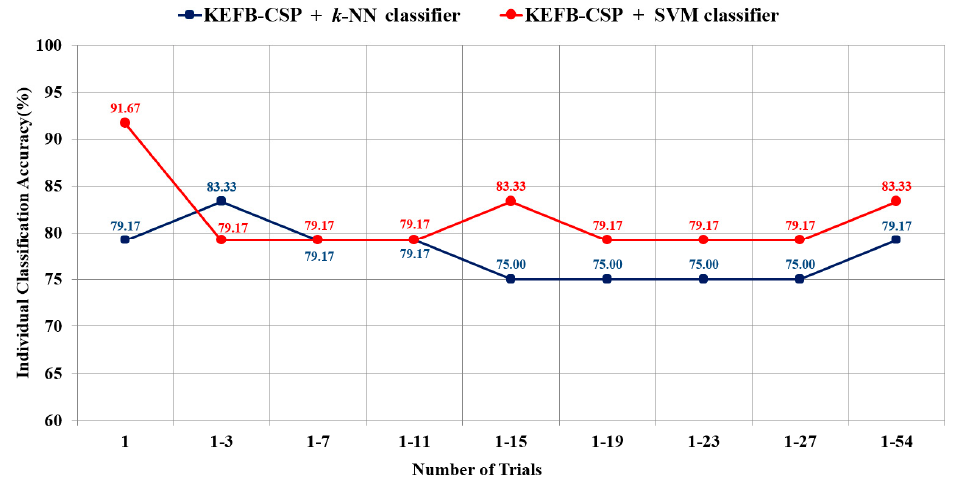
Figure 4. Voting-based individual classification accuracy versus the number of the first n t trials. The KEFB-CSP features were all extracted from the eight electrodes over the temporal scalp area.